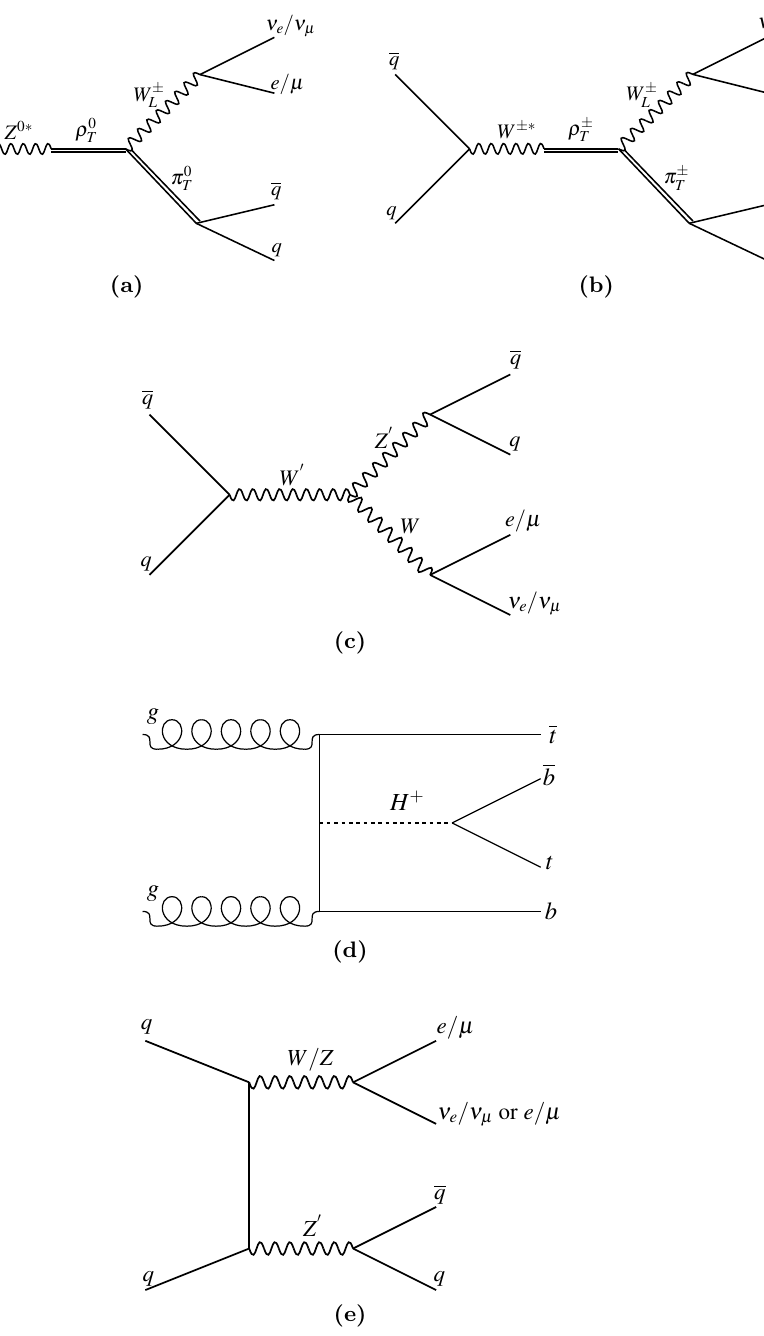
Figure 1. Representative Feynman diagrams for the processes considered in this analysis: (a)-(b) the techicolor model with production of (cid:26) T decaying into (cid:25) T W (cid:6) , (c) W 0 the Sequential Standard Model, (d) the charged Higgs boson production in association with a top quark, tbH + , (e) the simpli(cid:12)ed dark-matter model.